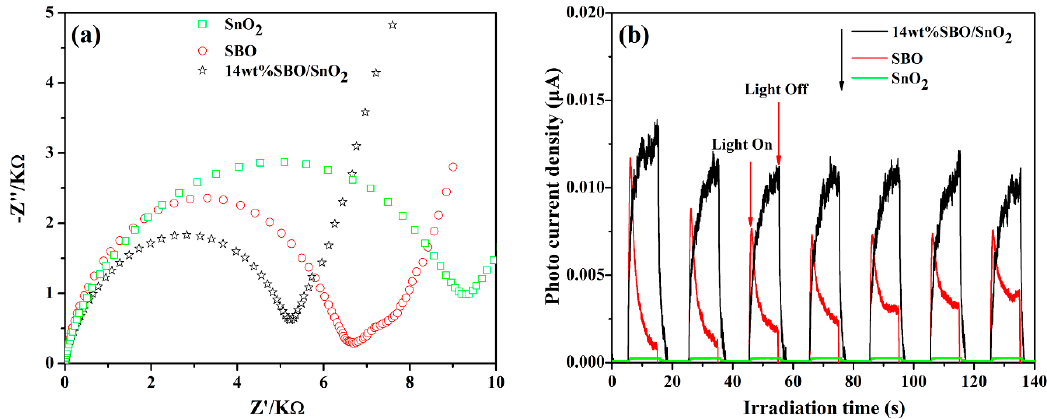
Figure 7. ( a ) Electrochemical impedance Spectroscopic plots and ( b ) transient photocurrent response of pure SnO 2 , SBO, and 14 wt% SBO/SnO 2 heterojunction.